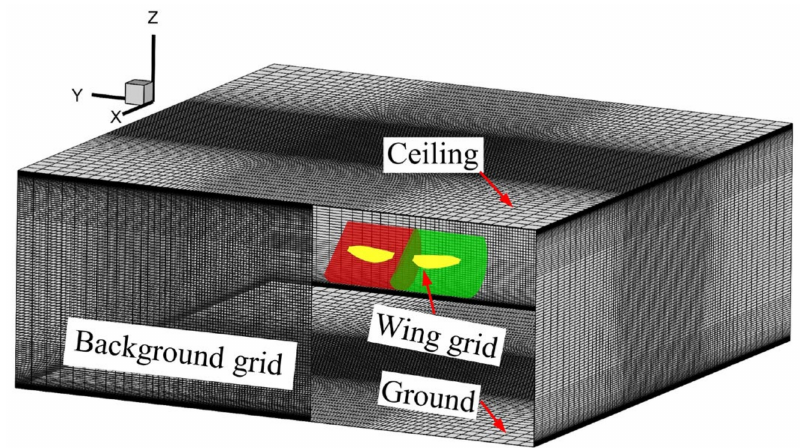
Figure 3. Wing meshes in a background